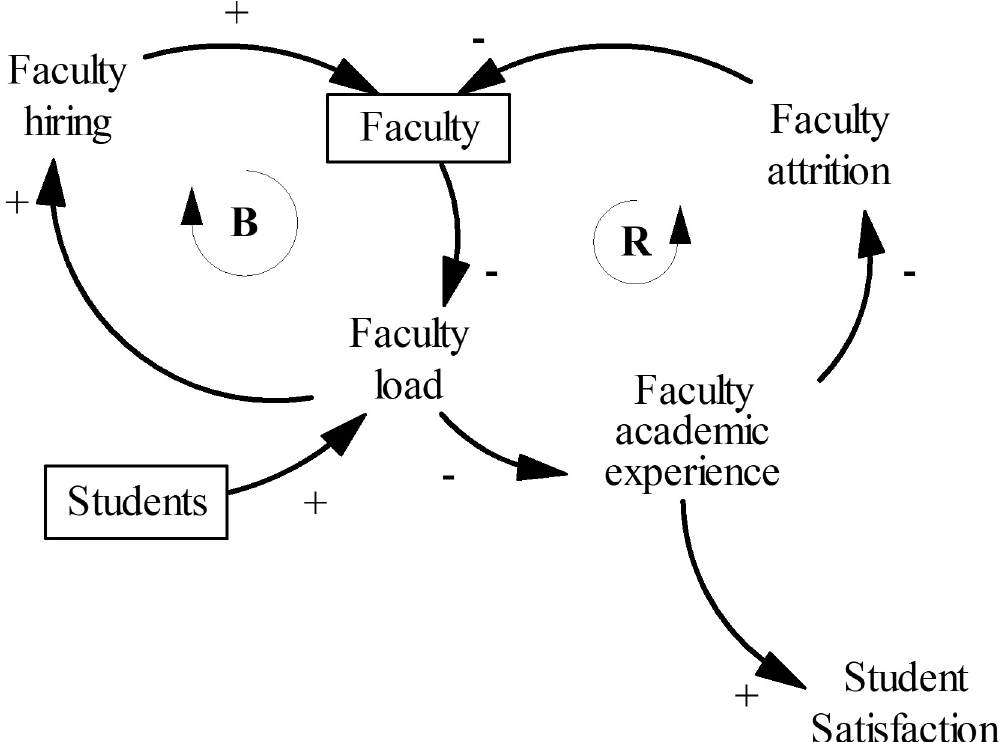
Fig 3. Causal structure of the faculty sector. The letter B signifies a balancing loop. The letter R is for a reinforcing loop.